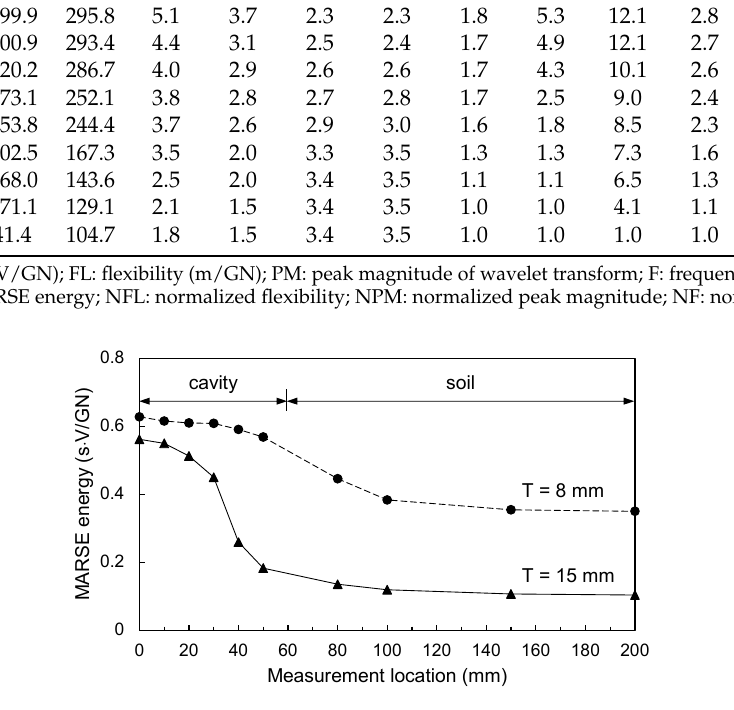
Figure 8. MARSE energies according to measurement location.